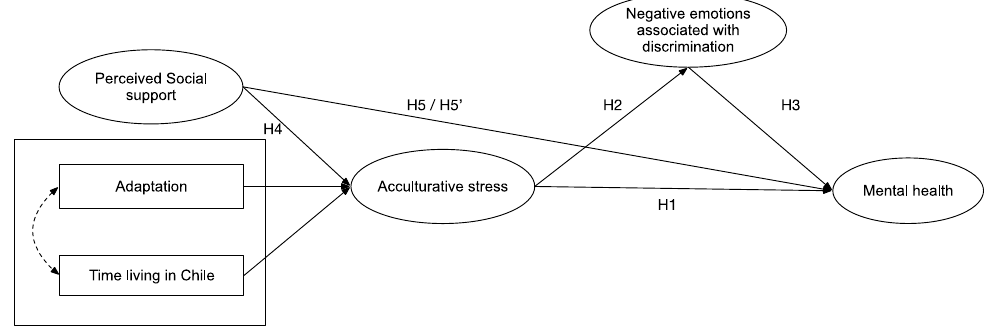
Figure 1. Proposed Model and Hypothesis.